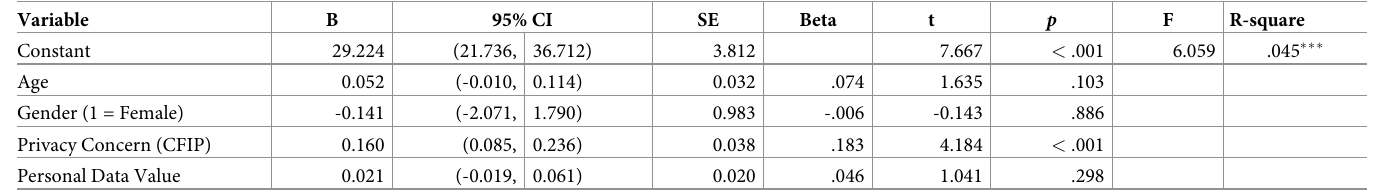
Table 2. Regression predicting privacy behaviour from demographic variables, privacy concern, and personal data value, Study